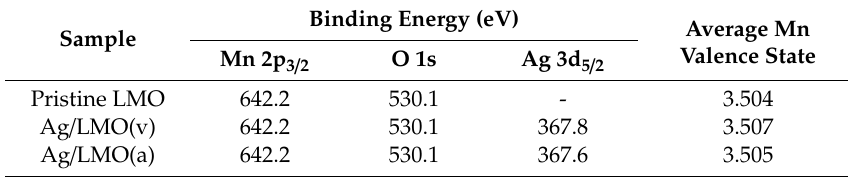
Table 3. XPS analysis of pristine LMO and Ag/LMO composites .